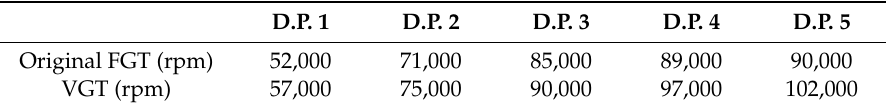
Table 18. Comparison between the original FGT rotational speed and the rotational speed obtained with VGT.